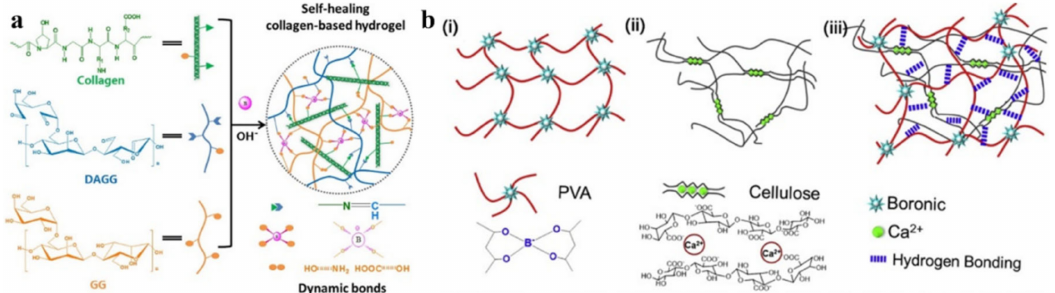
Figure 56. ( a ) Mechanism of collagen-guar gum hydrogel construction, including imine bonds, diol-borate ester bonds, and supramolecular interactions. Reproduced from [235] with permission from John Wiley and Sons. ( b ) Structure of the hydrogel network: ( i ) PVA hydrogel, ( ii ) cellulose nanofibril, and ( iii ) diagram of the PVA / cellulose nanofibril hydrogel network. Reproduced from [236] with permission from Elsevier.